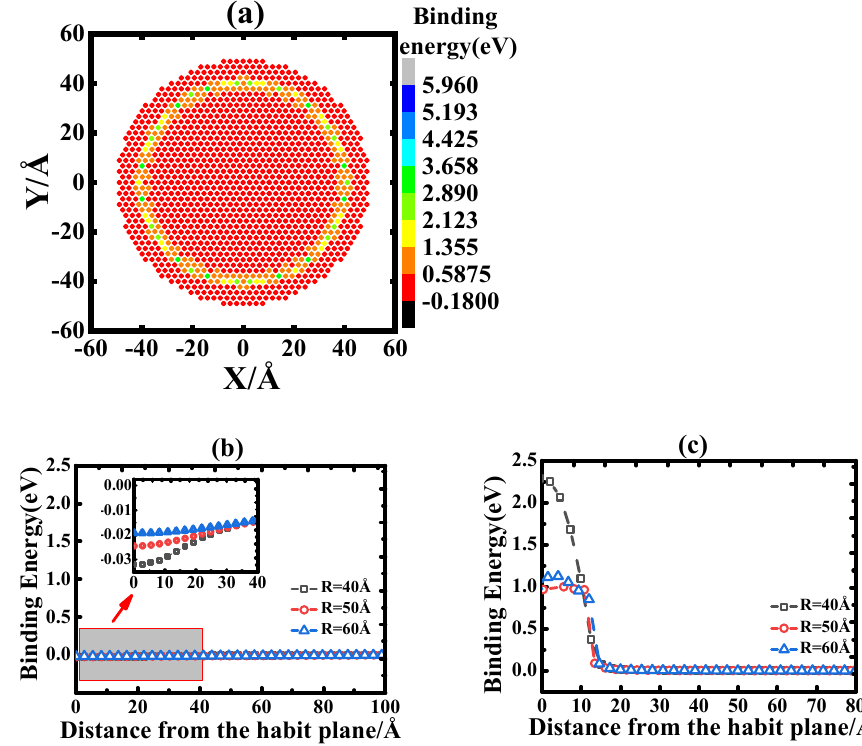
Figure 3. The distribution of binding energies of a VDL to a vacancy when the vacancy is placed on ( a ) HP, along ( b ) the Direction I and ( c ) Direction II, respectively. The inset figure shows the binding energies at a small energy scale.